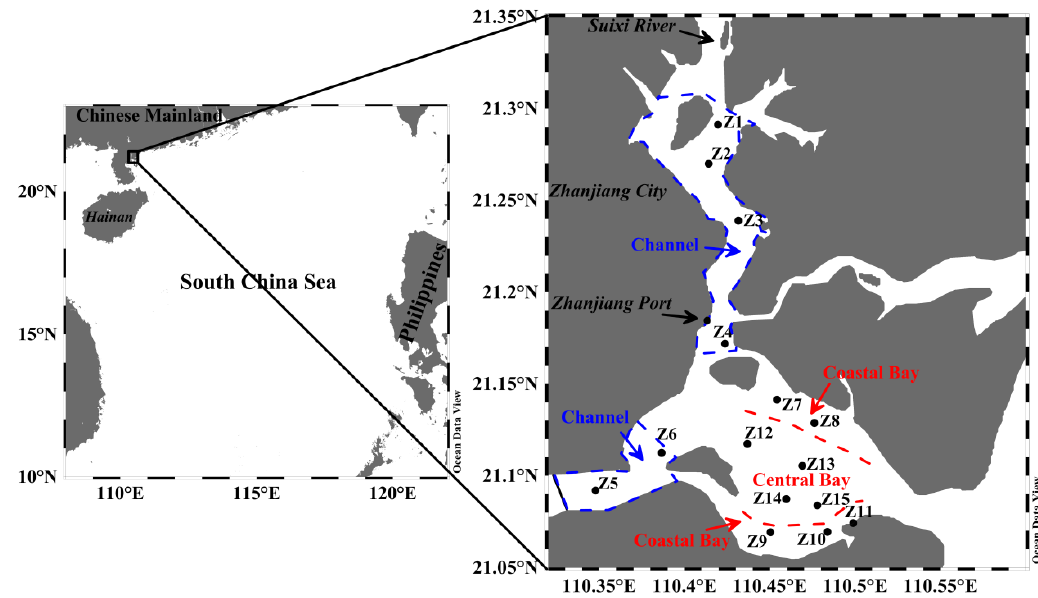
Figure 1. The sampling sites (Z1–Z15) in Zhanjiang Bay (ZJB), China. Zhanjiang Bay is divided into three subregions, namely the channel, coastal bay, and central bay.